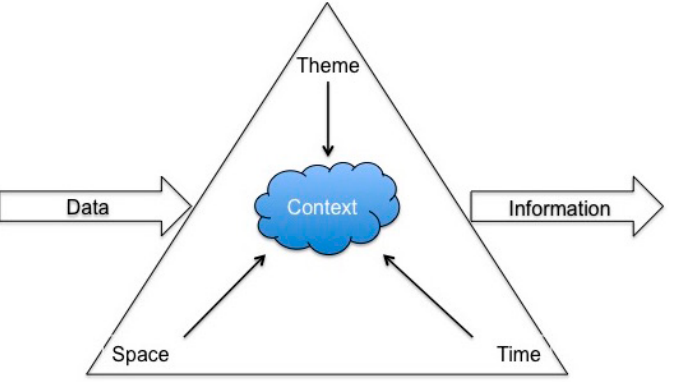
Figure 1. Simple conceptual model for learning context from integration of spatial, temporal, and thematic properties of Internet data sources within a surveillance system.